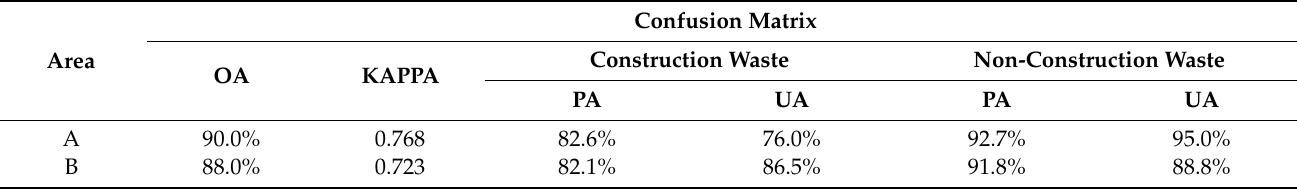
Table 6. Accuracy evaluation of the construction waste identification.